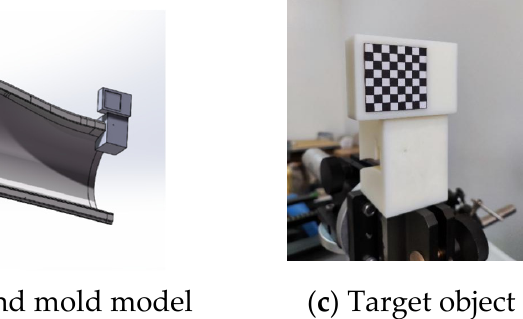
Table 6. Pose information solved by camera and scanning galvanometer.